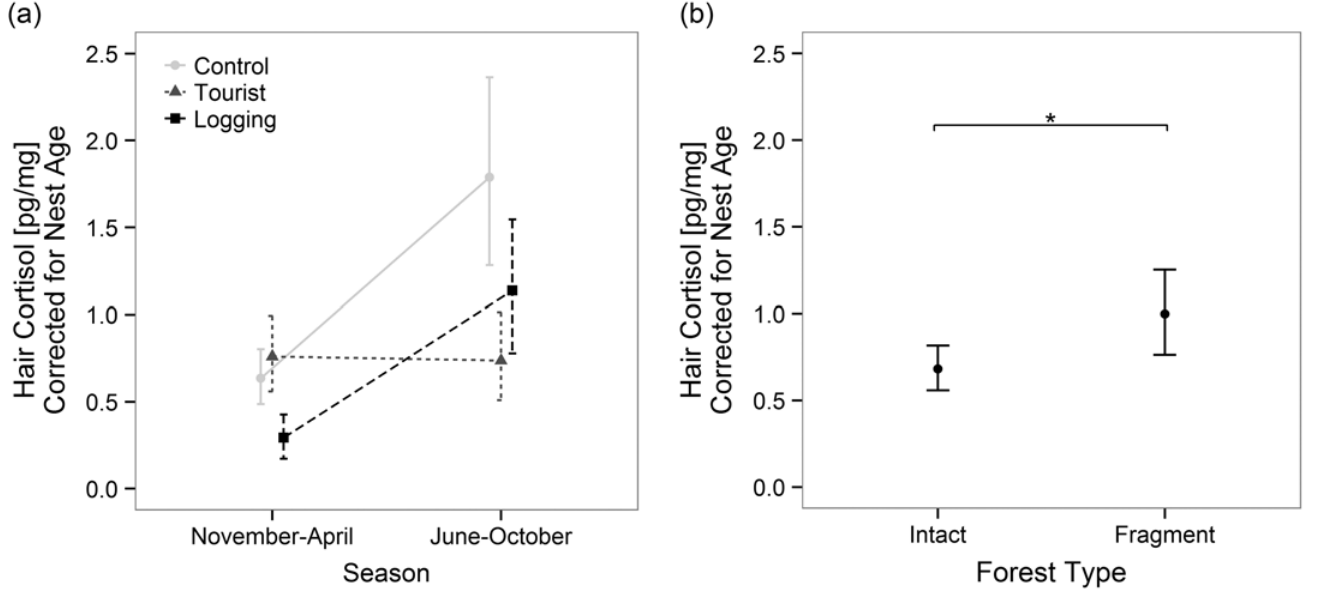
Fig 2. Differences in hair cortisol concentrations between seasons and chimpanzee communities with diverse anthropogenic impacts. Residualized mean hair cortisol concentrations (accounting for nest age effect) with 95% CI in different chimpanzee groups and seasons. (a) Chimpanzees did not exhibit significantly more cortisol due to tourism or logging in comparison to the control group without human contacts. A significant effect of seasonality [ F (2,129) = 37.4, p < 0.0001, r 2 = 0.18] was presumably unrelated to human impacts. (b) The comparison of hair cortisol concentration between chimpanzees living in an intact forest and those in a forest fragment with severe human-wildlife conflicts revealed significantly elevated HCC in the latter group [ F (1,88) = 5.0, p = 0.03, r 2 = 0.20].